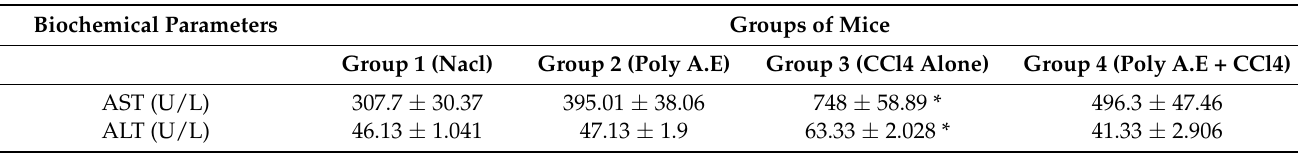
Table 2. Blood chemistry values of mice treated with NaCl (group 1), A. europaea polyphenols (poly A.E) (group 2), CCl4 alone (group 3), CCl4 combined of 50 mg/kg of the polyphenol-rich fraction (group 4). Biochemical Parameters Groups of